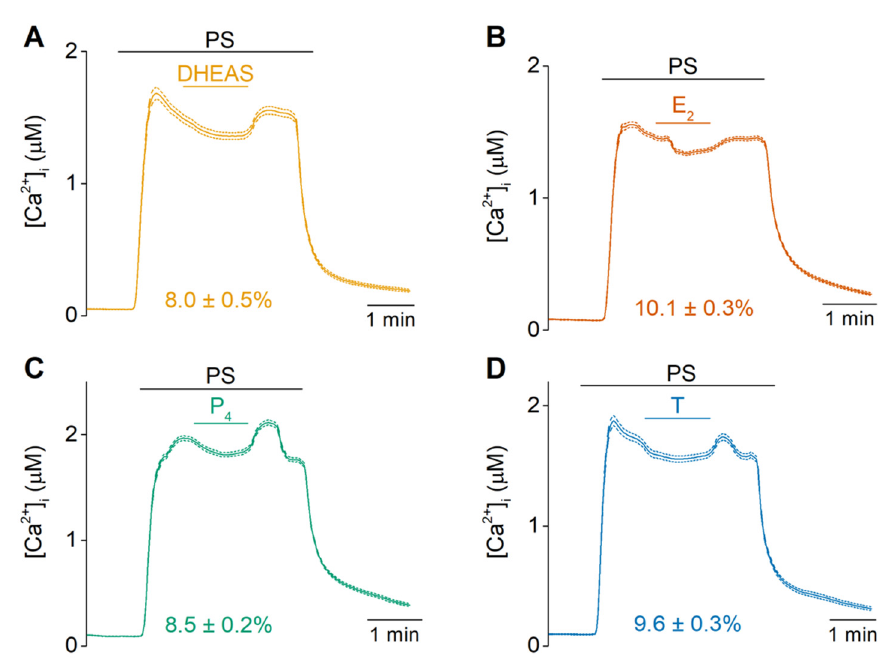
Figure 4. Evidence for competition between PS and DHEAS, estradiol, progesterone or testosterone. ( A – D ) Time course of intracellular calcium concentrations ([Ca 2+ ] i ) of HEK-TRPM3 upon application of 40 µM PS, followed by a coadministration with 100 µM DHEAS, E 2 , P 4 or T, respectively. Com- petitive antagonism results in a block of PS-response by 8.0 ± 0.5% (N = 2, n = 667), 10.1 ± 0.3% (N = 4, n = 1649), 8.5 ± 0.2% (N = 2, n = 840), and 9.6 ± 0.3% (N = 3, n = 1387), respectively. Data are represented as mean ± SEM.